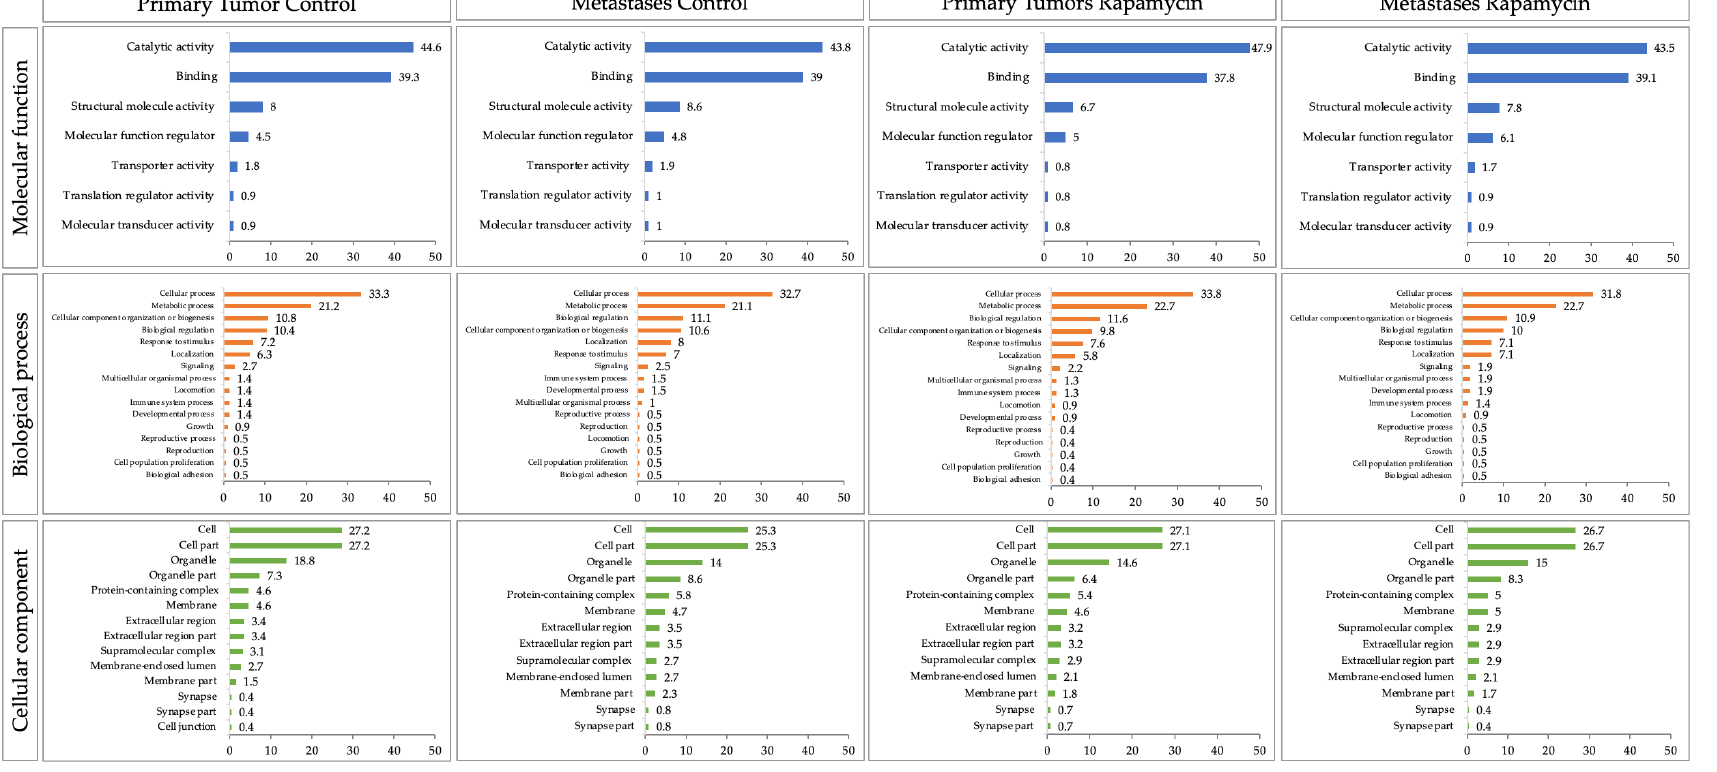
Figure 3. Gene ontology (molecular function, biological process, and cellular component) of primary tumor control, metastases control, primary tumor rapamycin and metastases rapamycin groups.